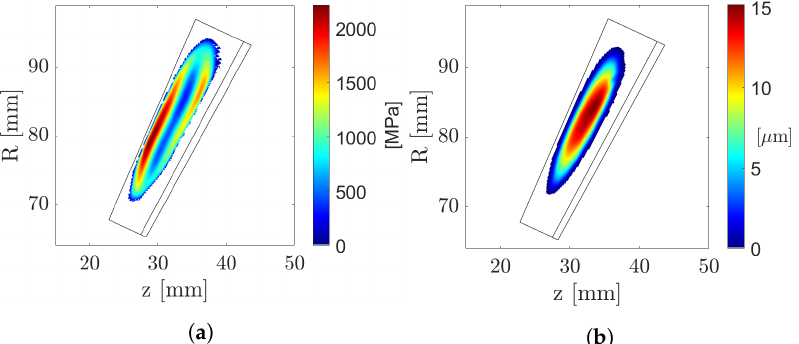
Figure 11. Gear patterns after 30 Mc (pinion revolutions) cycles. Only one geometry update is per- formed. ( a ) Contact pattern. ( b ) Wear